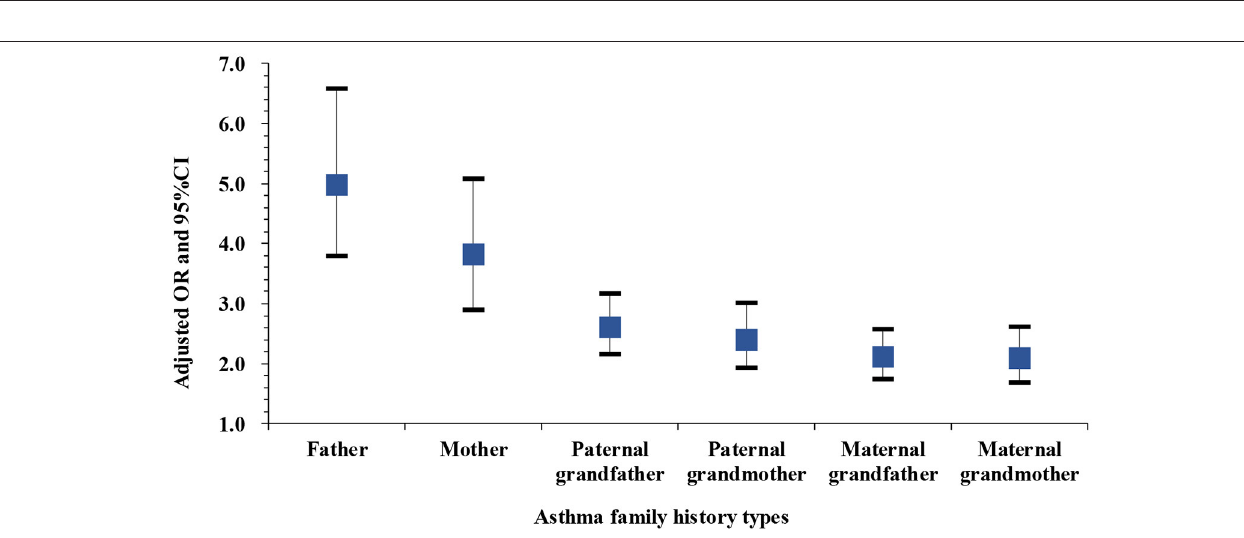
FIGURE 2 | Adjusted ORs and 95%CIs for asthma among children with one family member affected by asthma compared to those without any family member affected. Adjusted for passive smoke exposure, home coal use, pet kept and PM 2.5 exposure. Asthma cases: 75 cases with affected fathers, 67 cases with affected mothers, 132 cases with affected paternal grandfathers, 97 cases with affected maternal grandfathers, 119 cases with affected paternal grandmothers, and 95 cases with maternal